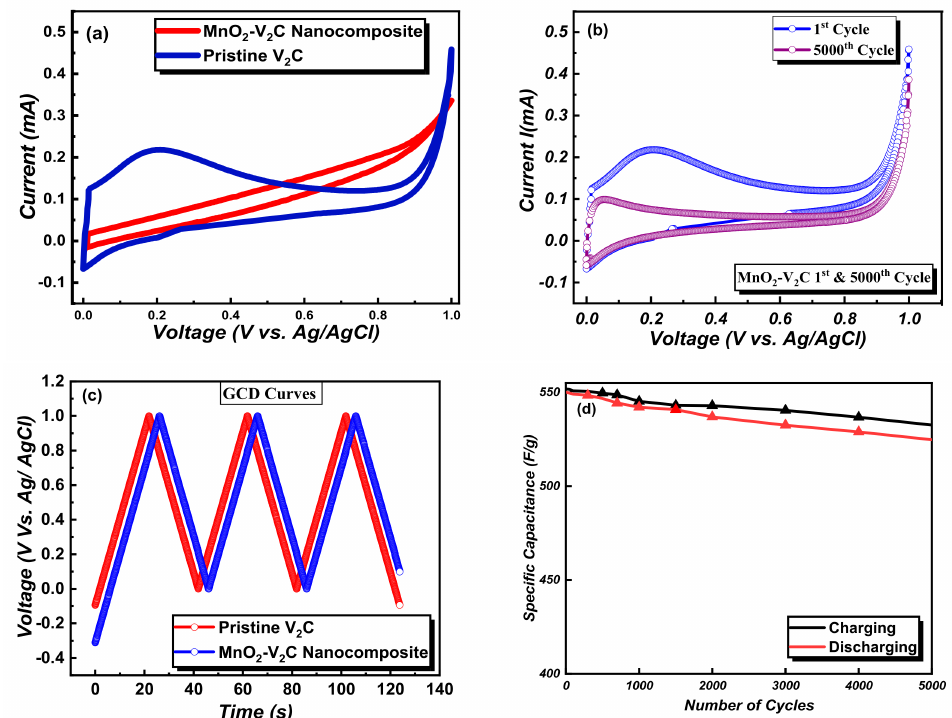
Figure 5. ( a ) Current vs. voltage of pristine MXene and MnO 2 -V 2 C nanocomposite, ( b ) comparison of 1st and 5000th cycle of MnO 2 -V 2 C nanocomposite, ( c ) galvanostatic charge–discharge curves of V 2 C and MnO 2 -V 2 C, ( d ) specific capacitance vs. number of